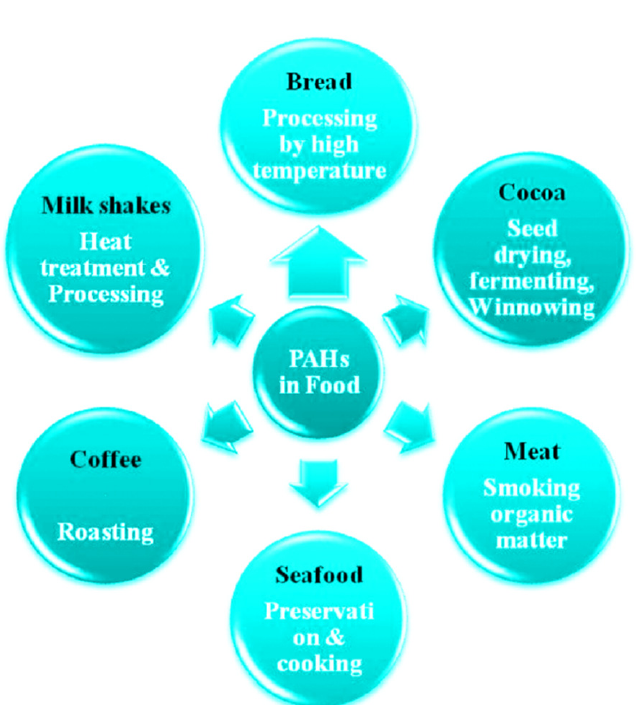
Figure 1. The Food Supply Contaminated With PAHs From many Different Sources (License Number: 5411951000689) [29] . Table 1. Characteristics of physical–chemical priority compounds of PAH contaminants [29,30].